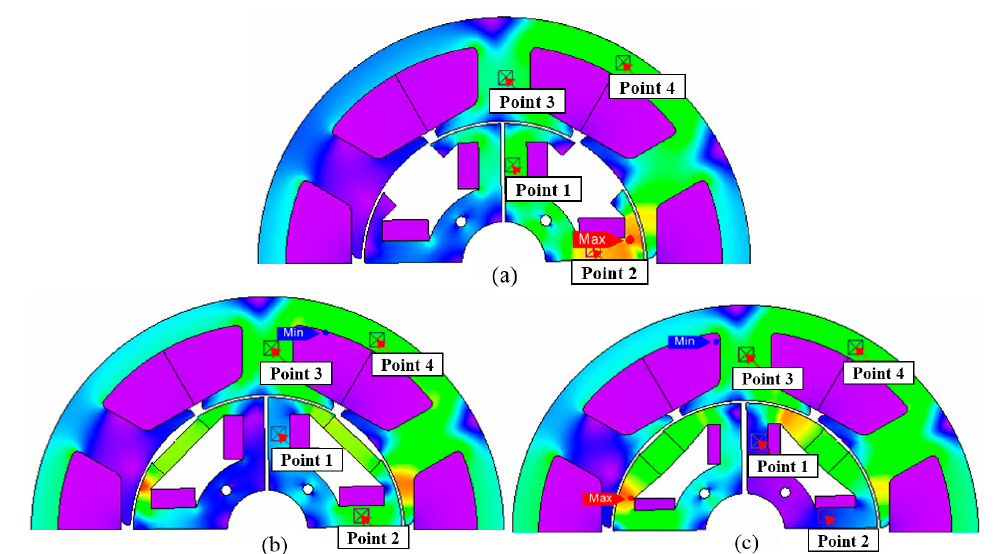
Figure 17. Magnetic flux density distribution at the maximum torque condition: ( a ) Basic model; ( b ) Proposed model; ( c ) Optimal model.